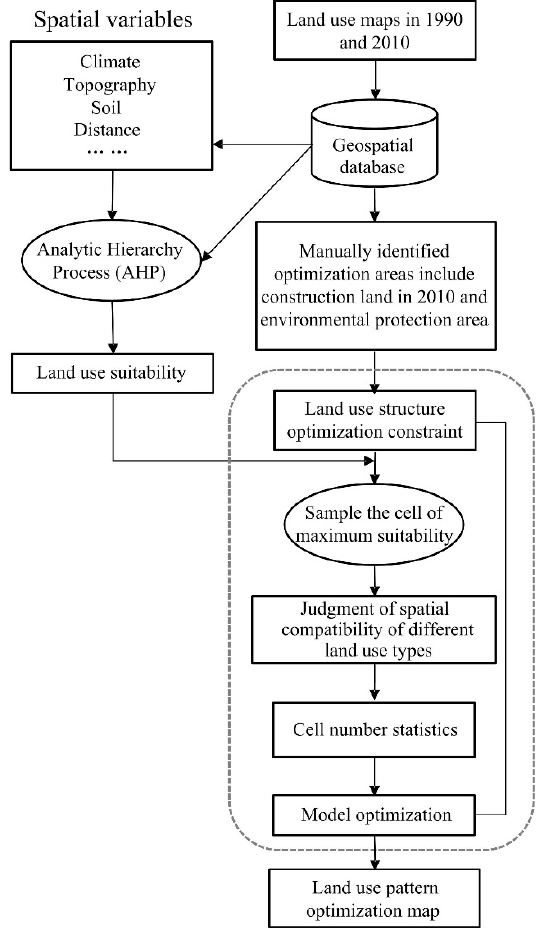
Figure 4. Technological flowchart of the land use pattern optimization integrated climate change adaptation and mitigation.